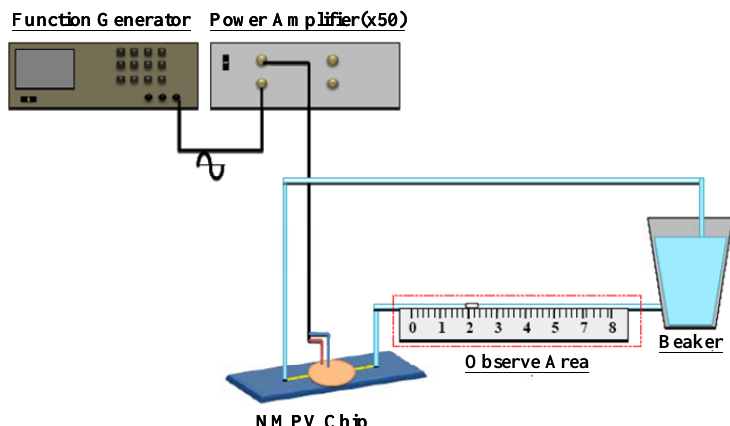
Figure 10. Diagram for the